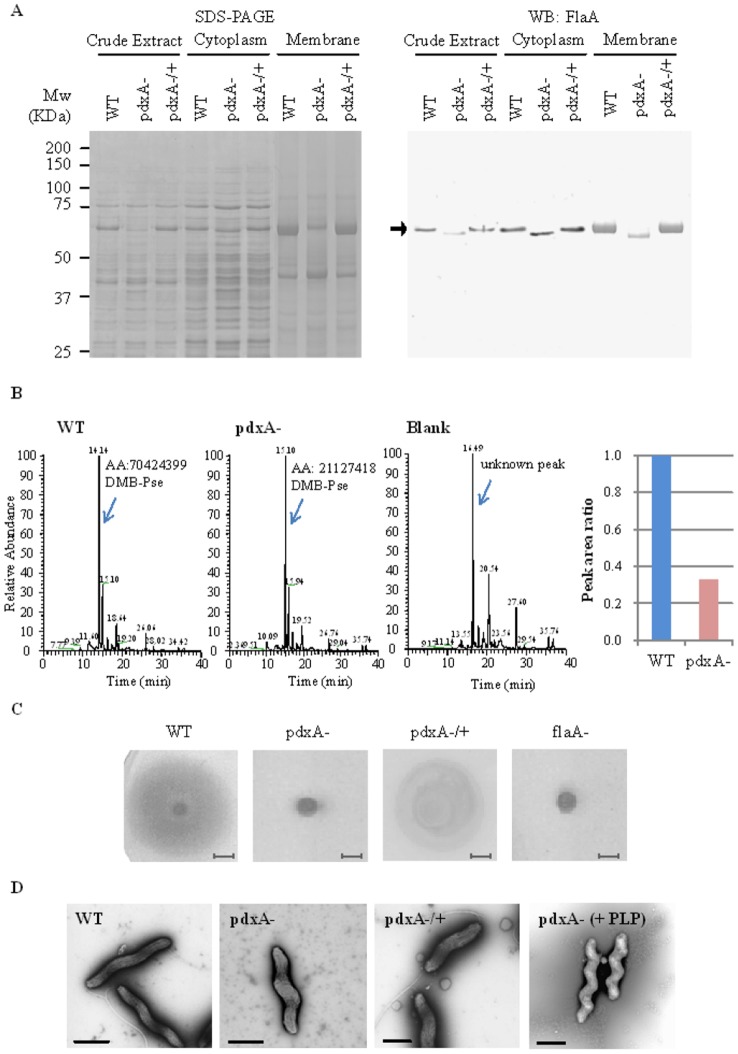
The pdxA mutant shows impaired pseudaminic acid (Pse) production and flagellar motility.(A) The pdxA mutant shows less glycosylation of FlaA. SDS-PAGE and western blotting were conducted to detect the C. jejuni FlaA protein. Crude extracts and subcellular (cytoplasmic and membrane) fractions were extracted from C. jejuni and visualized using CBB staining in an SDS-polyacrylamide gel (left panel). Western blot analyses were simultaneously performed to detect the FlaA protein (arrow, right panel). (B) The pdxA mutant shows reduced Pse production. The left panel shows an extracted ion chromatogram at m/z 441.0–461.0 obtained through SIM of DMB-labeled Pse from the WT and pdxA mutant strains (arrowed). The extracted ion chromatogram of blank sample (fresh MH broth) was simultaneously subjected to confirm the absence of Pse. AA, peak area in arbitrary units. Each ion signal is expressed as a relative percentage of the WT-derived sample (set to 100%) from two independent tests (right panel). MSn data were shown in Fig. S1, S2, S3. (C) The disruption of the pdxA gene impairs motility of C. jejuni. The WT, pdxA mutant, pdxA-complemented (pdxA−/+), and flaA mutant (flaA-) strains were spotted and incubated onto 0.4% soft agar. Scale bars represent 3 mm. The motility of pdxA mutant was also assayed in the supplementation of 10 mg l−1 of PLP (pdxA− + PLP). (D) The pdxA mutant is aflagellated. Electron micrographs of the C. jejuni WT, pdxA mutant with or without supplementation of PLP (10 mg l−1), pdxA- complemented strains. The scale bars represent 1 μm.